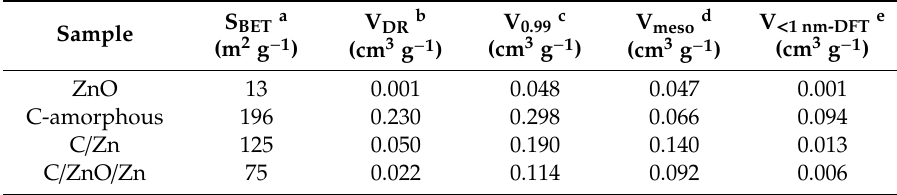
Table 2. List of the textural properties of the samples.